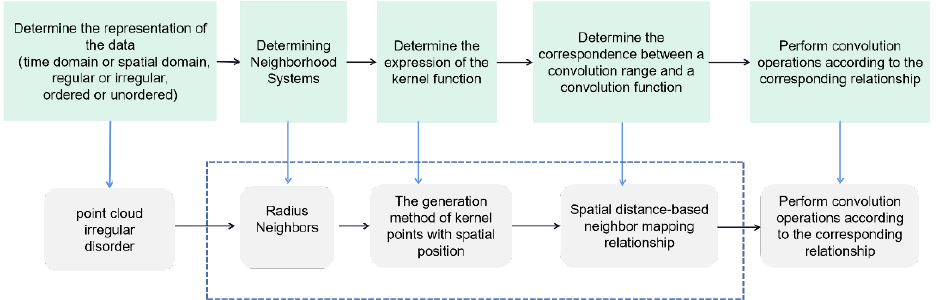
Figure 1. The convolution framework of 3D point clouds: The upper section gives the definition of a general convolution framework. The bottom section describes convolution according to this study. Having different choices for the elements in the red dashed box will produce different convolution operations.